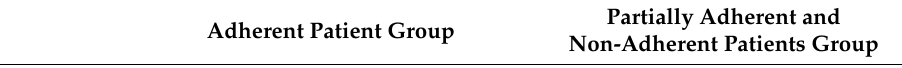
Table 2. Change in distribution of NYHA class from baseline to week 9 comparison by degree of patients’ adherence to hybrid comprehensive